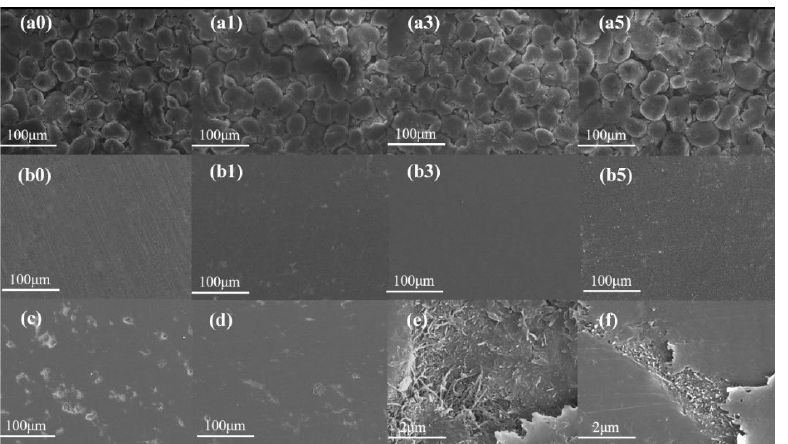
Figure 2. SEM images: ( a0 ) PEEK green-compact, ( a1 ) 1 wt.% CNTs green compact, ( a3 ) 3 wt.% CNTs green compact, ( a5 ) 5 wt.% CNTs green compact, ( b0 ) DDP PEEK, ( b1 ) DDP 1 wt.% CNTs composites, ( b3 ) DDP 3 wt.% CNTs composites, ( b5 ) DDP 5 wt.% CNTs composites, and ( c – f ) magnified local defects in Figure 2 ( b5 ).